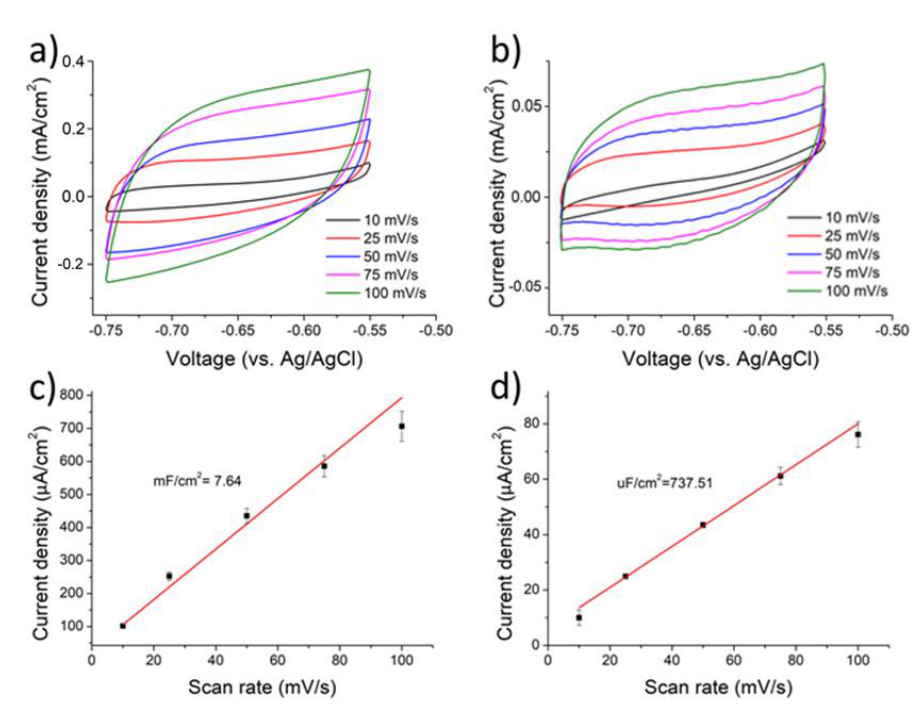
Figure 9. The CV scans in 0.1 M NaHCO 3 aqueous solution with a potential window of −0.75 and −0.55 V (vs Ag/AgCl): ( a ) Cu micromembrane and ( b ) planar Cu foil. The difference in current density as a function of scan rate: ( c ) Cu micromembrane and ( d ) planar Cu foil.